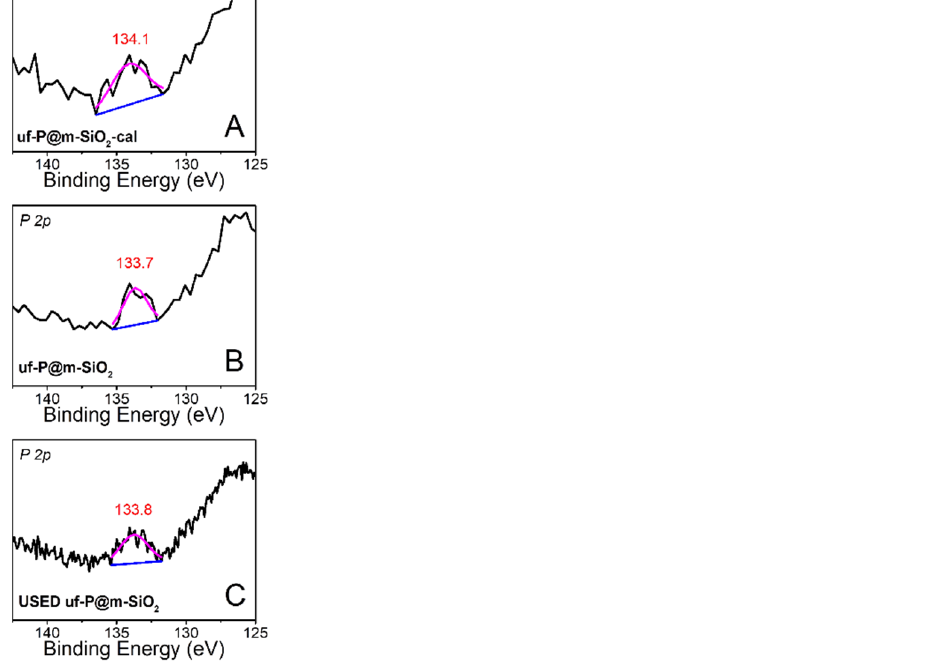
Figure 6. High-resolution XPS spectra of uf-P@m-SiO 2 -cal ( A ): fresh and uf-P@m-SiO 2 ( B ); fresh and ( C )